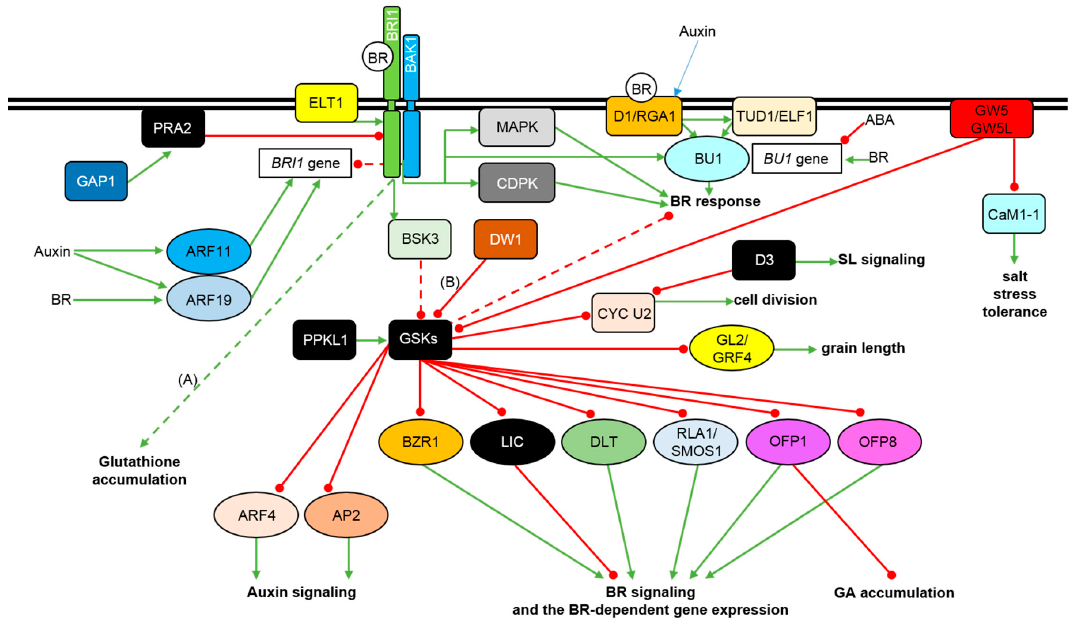
Figure 1. Model of the BR perception, signaling initiation, and regulation of the signal transduction in rice and other monocots. The BR molecule is depicted as the white circle with the ‘BR’ letters in it. Double black line represents the plasma membrane. Transcription factors are shown as ovals, other proteins are depicted as rectangles. Green arrows indicate stimulation, whereas red lines with the bullet points represent suppression. Detailed description is given in the text. Some of the BR responses and interactions were described in barley ( A ) and sorghum ( B ).